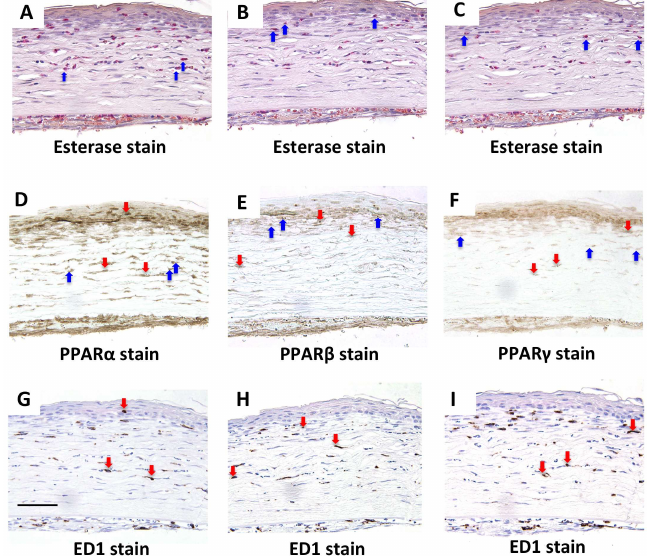
Figure 3. The expression and distribution of PPARs in rat cornea and infiltration of neutrophils and macrophages in alkali-burned cornea at day 7. In the alkali-burned cornea at day 7, serial sections stained with naphthol AS-D chloroacetate esterase ( A – C ), PPARα ( D ), PPARβ ( E ), PPARγ ( F ), and ED1 ( G – I ) showed that PPARs was expressed on infiltrating naphthol AS-D chloroacetate esterase positive-neutrophils (blue arrows) and ED1-positive macrophages (red arrows). Scale bar: 50 μm.